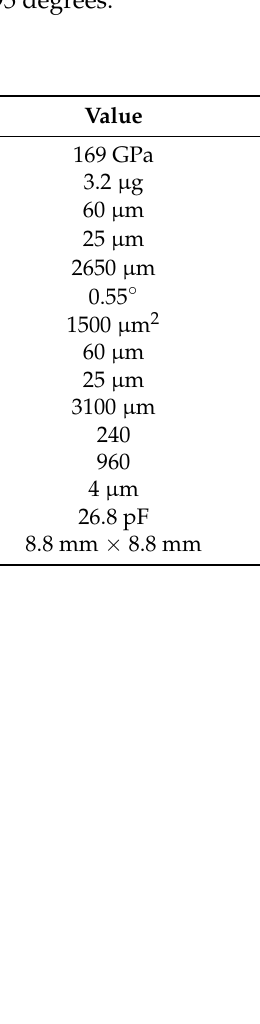
Table 1. Parameters of the proposed accelerometer